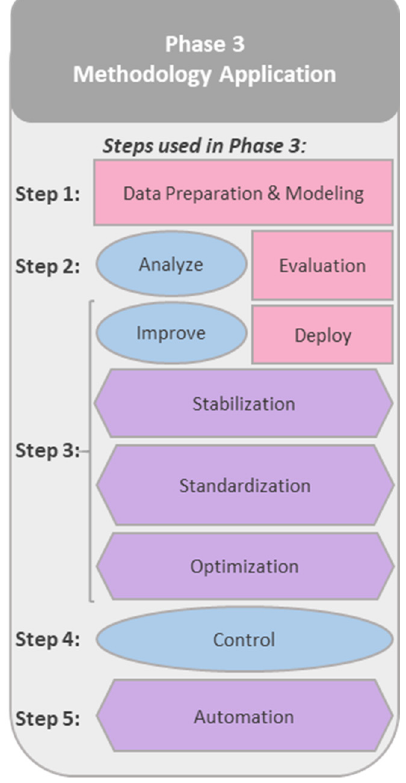
A plot of the capability index for all the DIMs is shown in Figure 13. Figure 12. Combined methodology—Phase 3. Figure 12. Combined methodology—Phase 3. Table 5. Capability study. Table 5. Capability study.